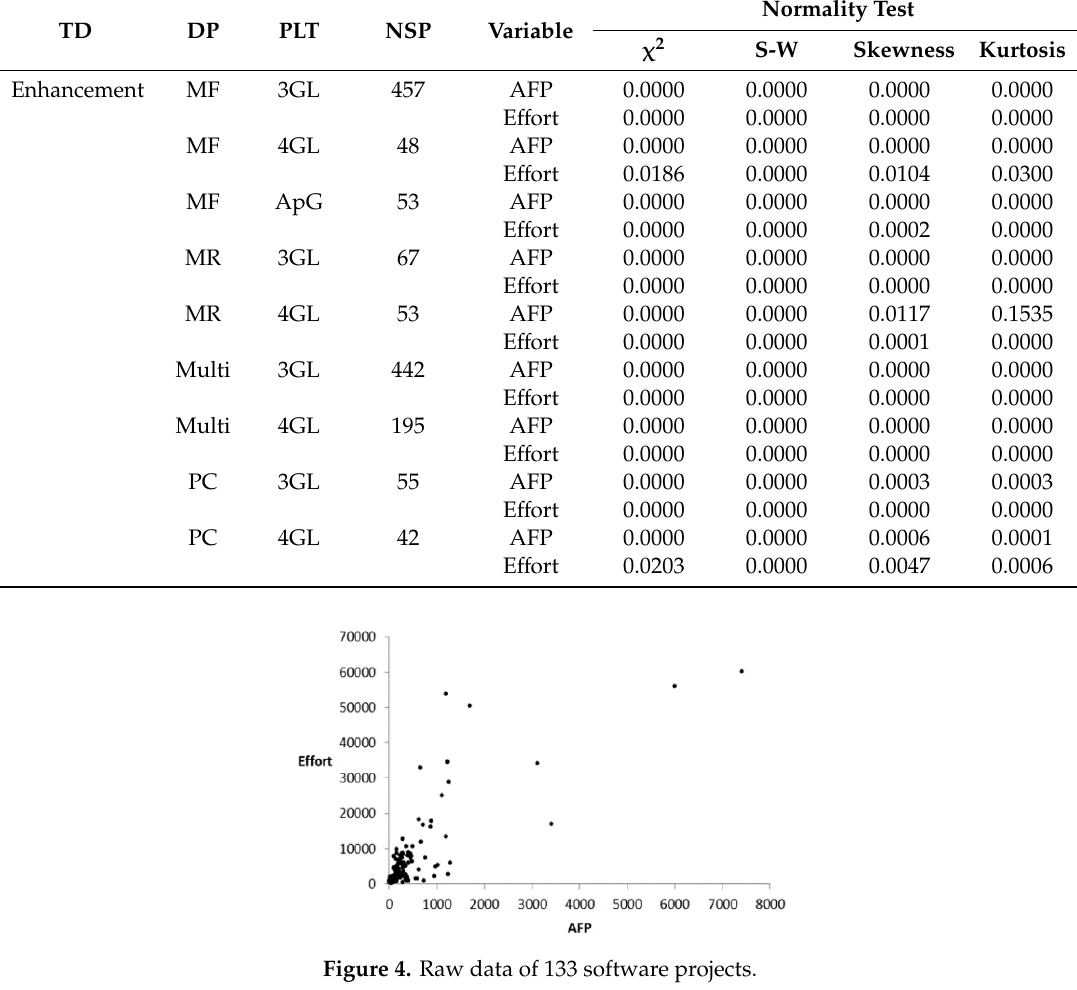
Figure 4. Raw data of 133 software projects.